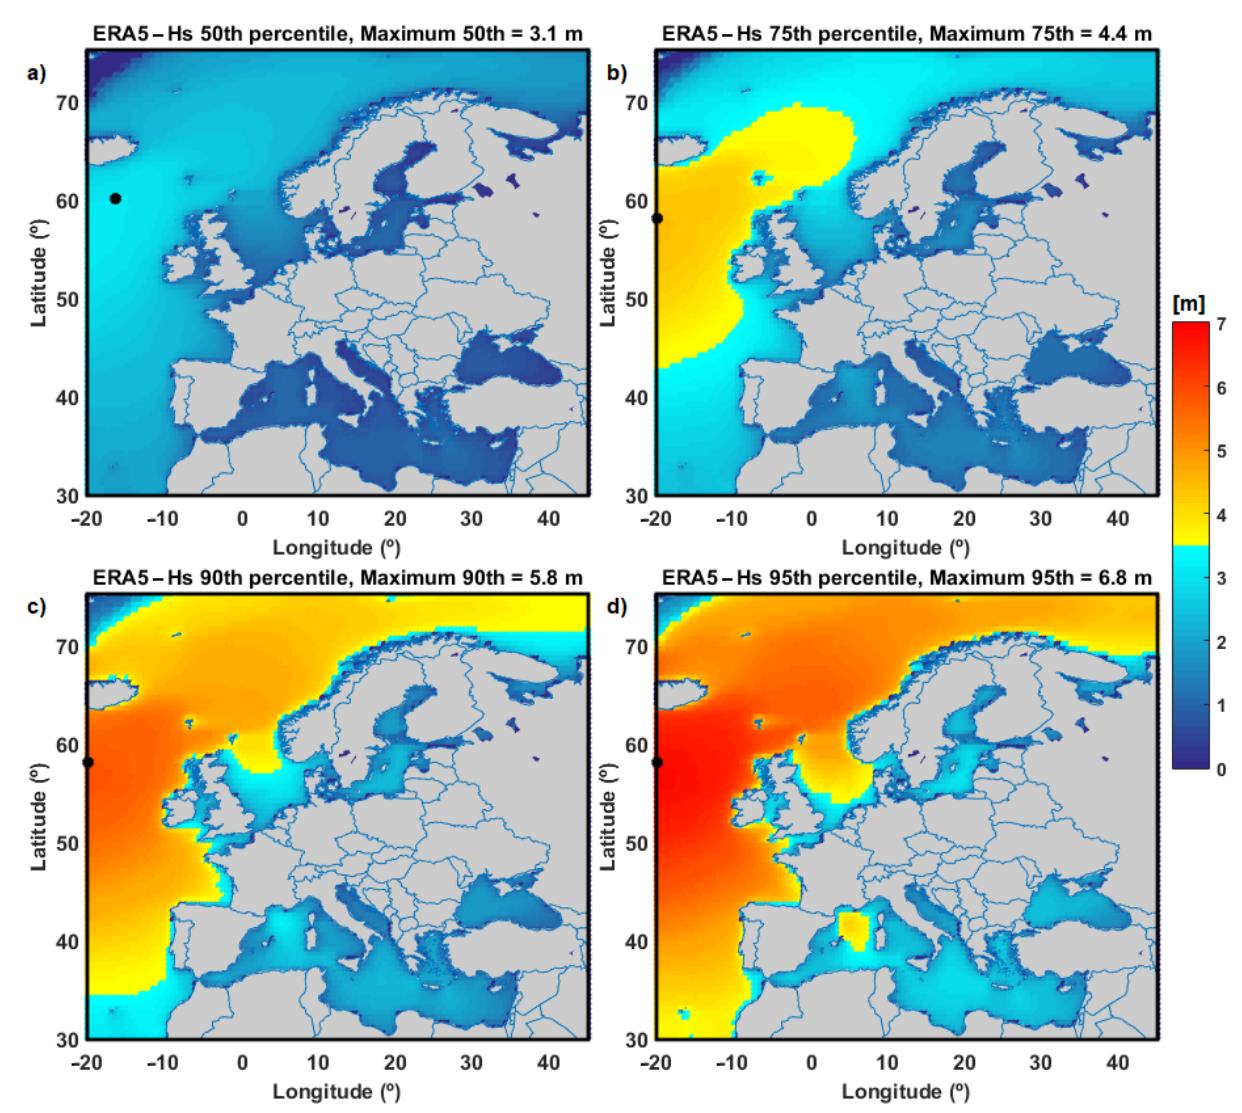
Figure 18. Statistical investigation on wave height conditions: ( a ) 50th percentile; ( b ) 75th percentile; ( c ) 90th percentile; ( d ) 95th percentile. Table 4. Maximum values of percentiles computed for Hs in each area considered.